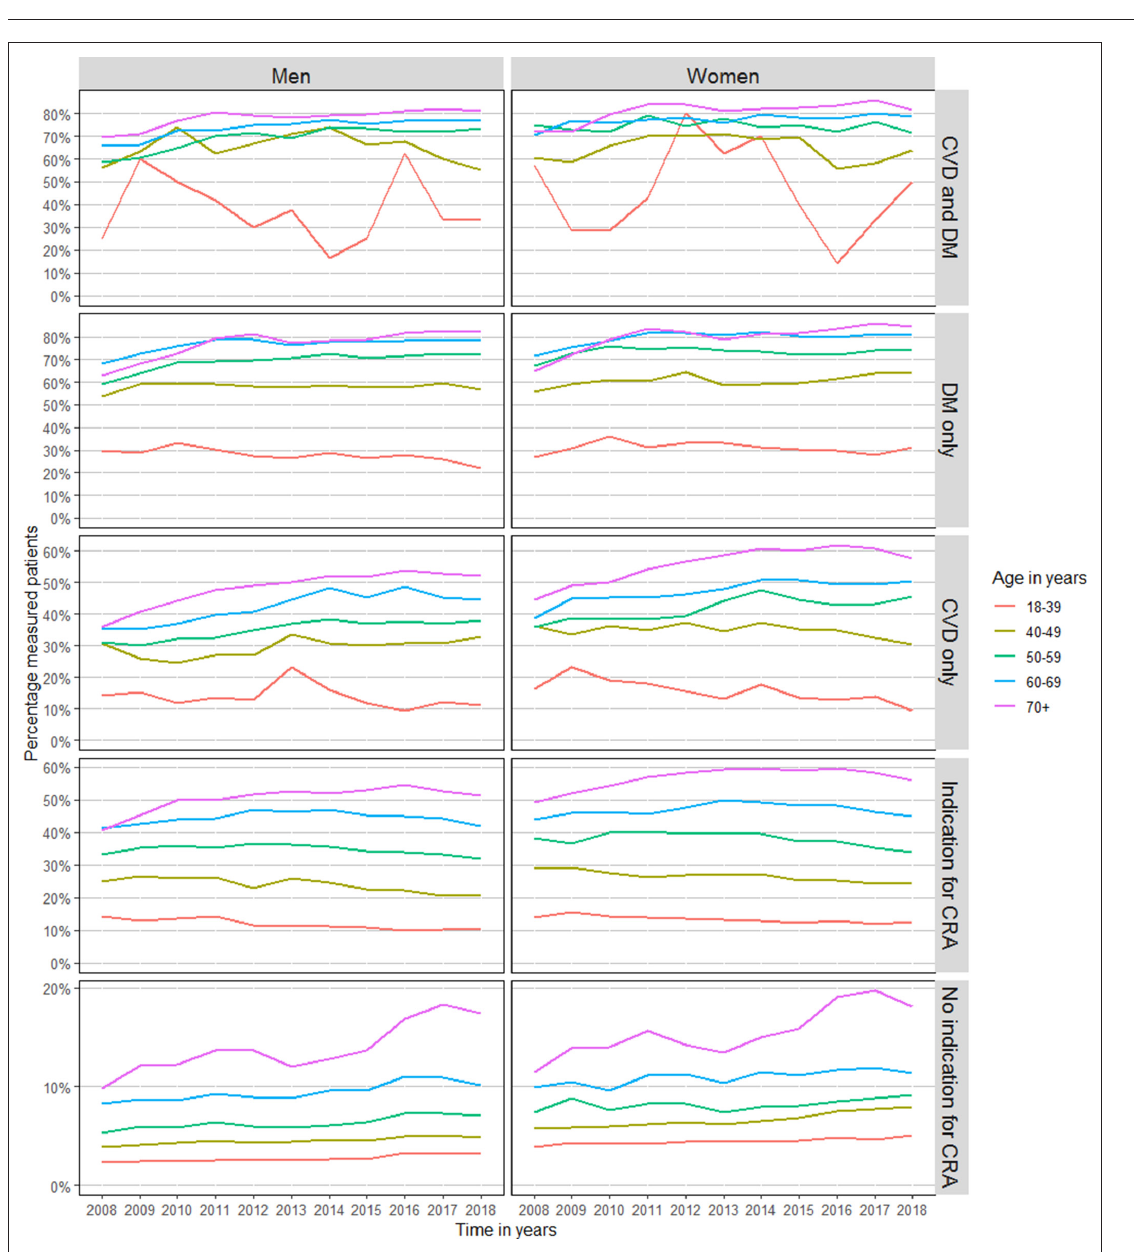
Figure 2 Sex and age stratified trends in annual BP measurement in patients with a history of CVD, DM, indication for CRA, or without an indication for CRA. Patients were classified as ‘Indication for CRA’ if they did not have a history of CVD or DM, but did have a history of one of the following: rheumatoid arthritis, pre- eclampsia, pregnancy- induced DM, family history of CVD, obesity, smoking, hypertension, dyslipidaemia, chronic kidney disease, use of antihypertensive or lipid- lowering medication. CRA = cardiovascular risk assessment. CVD = cardiovascular disease. DM = diabetes